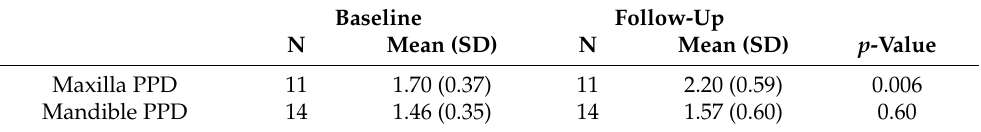
Table 4. Mean peri-implant pocket depth of maxilla and mandible sites at baseline and follow-up.